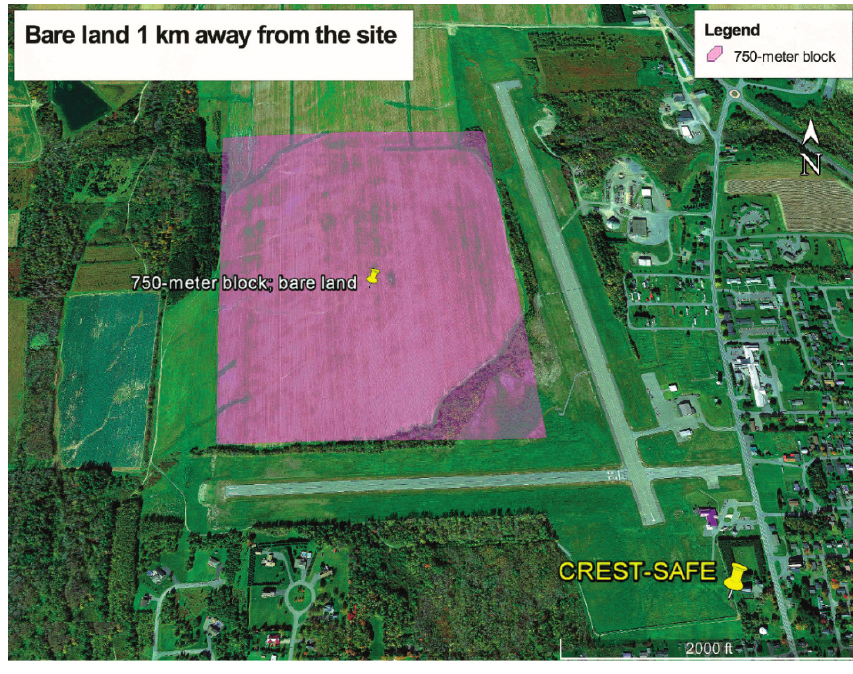
Figure 6 . 750 m block of bare land 1km away from CREST-SAFE.